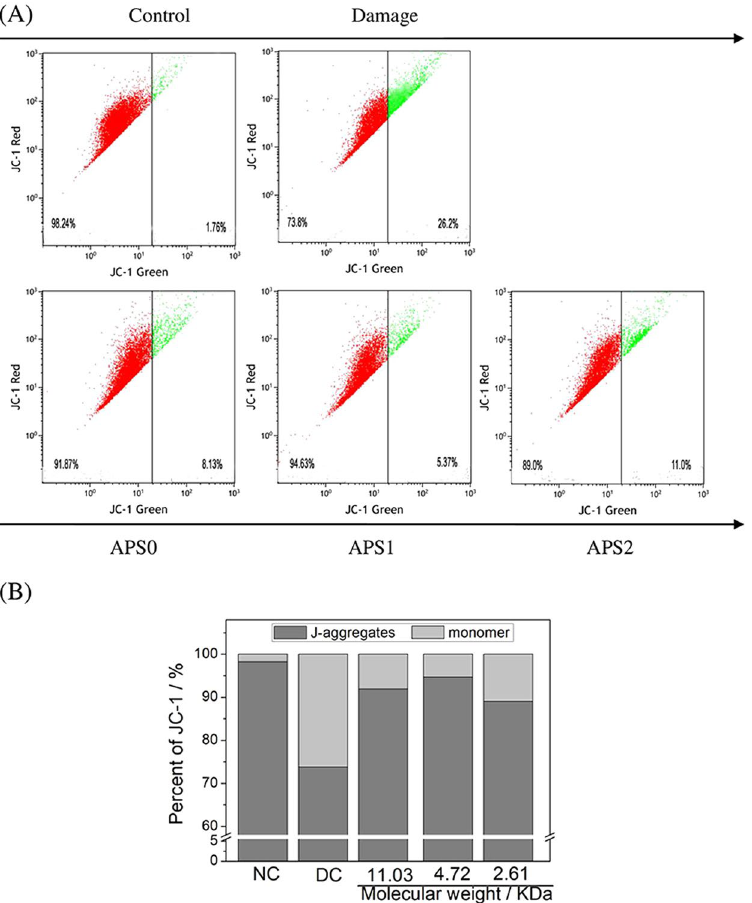
Figure 5. Changes in Δψ m of oxalate damaged HK-2 cells after repair by different Mw APS (60 μ g/mL) for 10 h. ( A ) Representative dot plot of Δψ m; ( B ) the aggregated degree of JC-1. JC-1 monomers (green fluorescence) represented the reduced Δψ